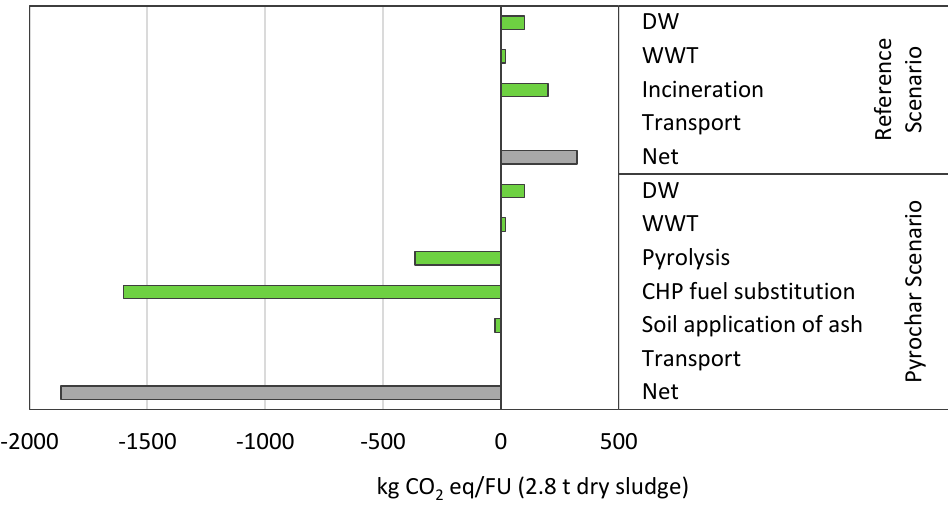
Figure 3. The climate change impact of Reference Scenario and Pyrochar Scenario including the processes and net values.